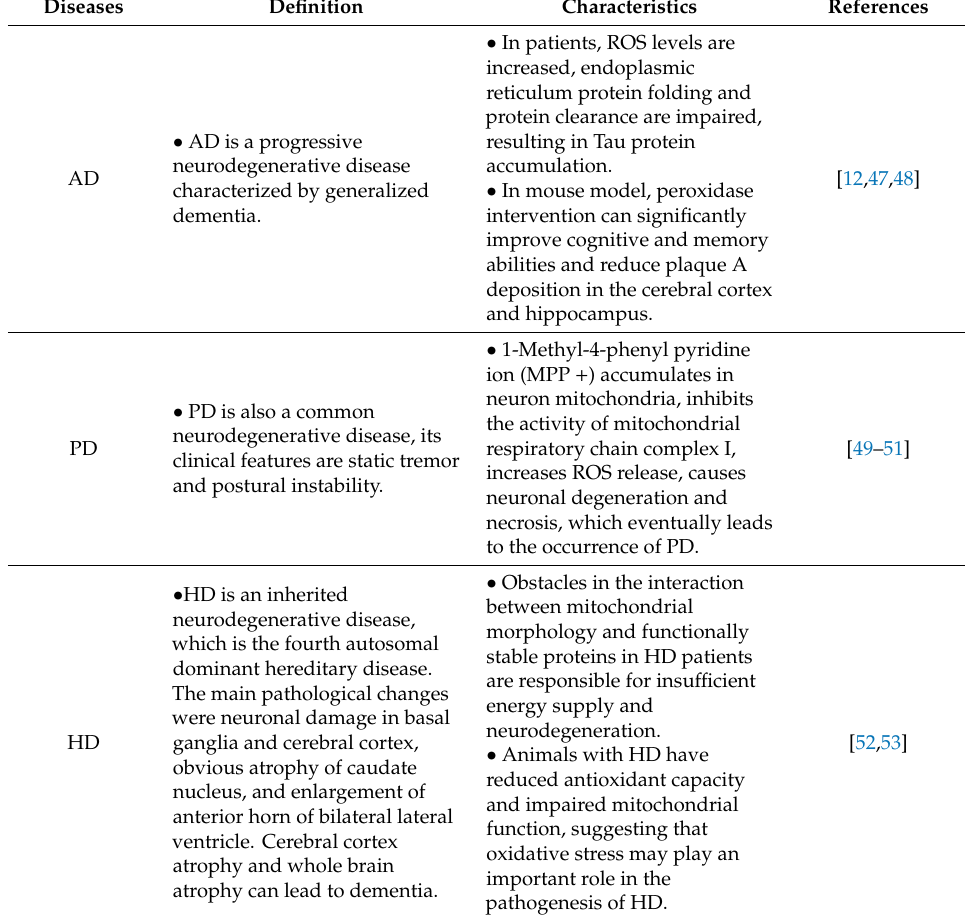
Table 1. Summary of the classification of neurodegenerative